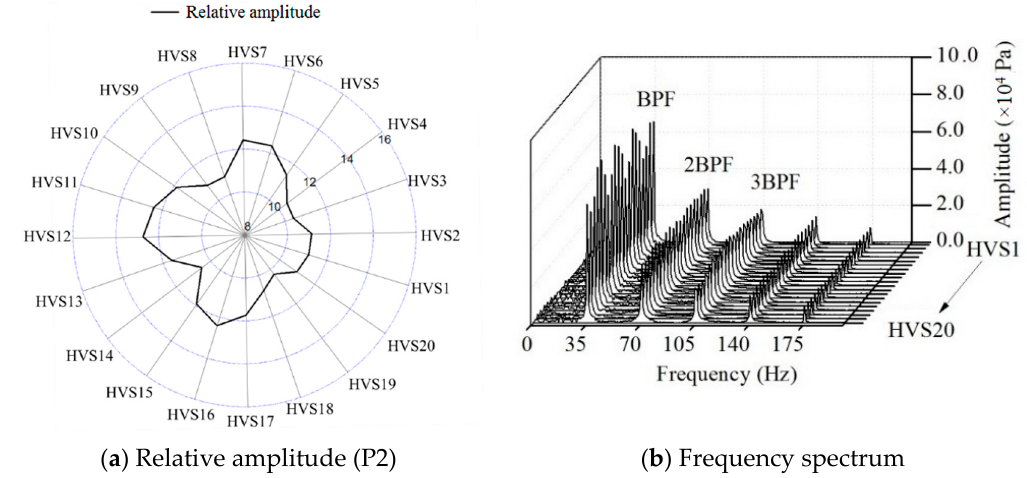
Figure 8. Relative amplitude and frequency of pressure fluctuations in vaneless space.